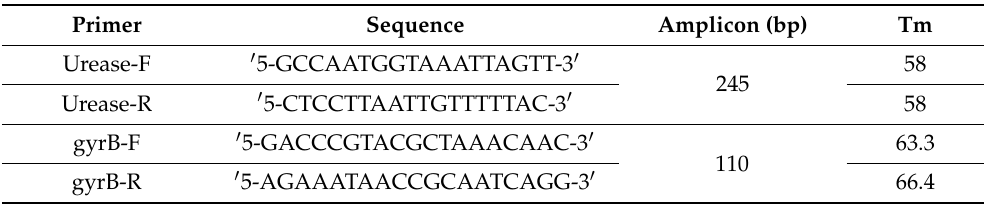
Table 3. Sequence and melting temperature of urease and gyrB genes, with primer size used in Quantitative Real-Time PCR method. Table 4. Conditions of PCR reaction.